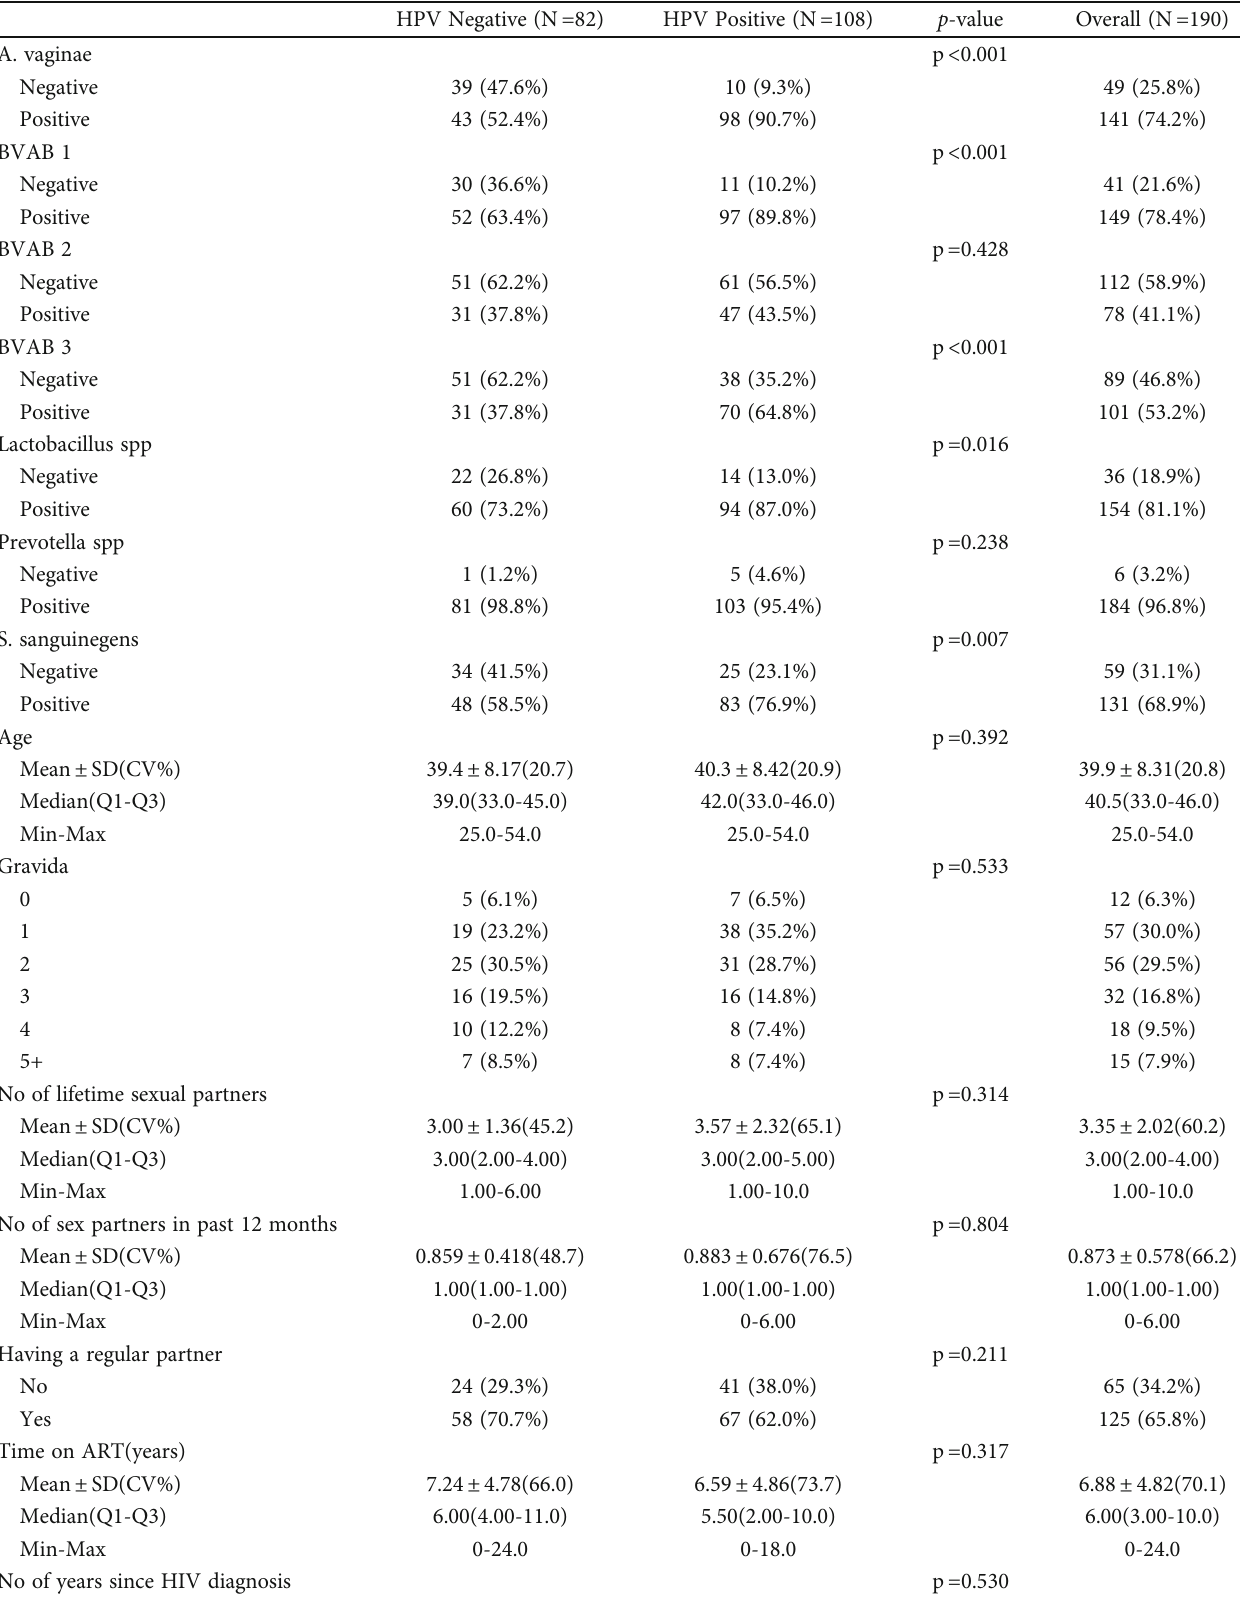
Table 2: Population characteristics and the association of BV associated bacteria in participants co-infected with HPV at